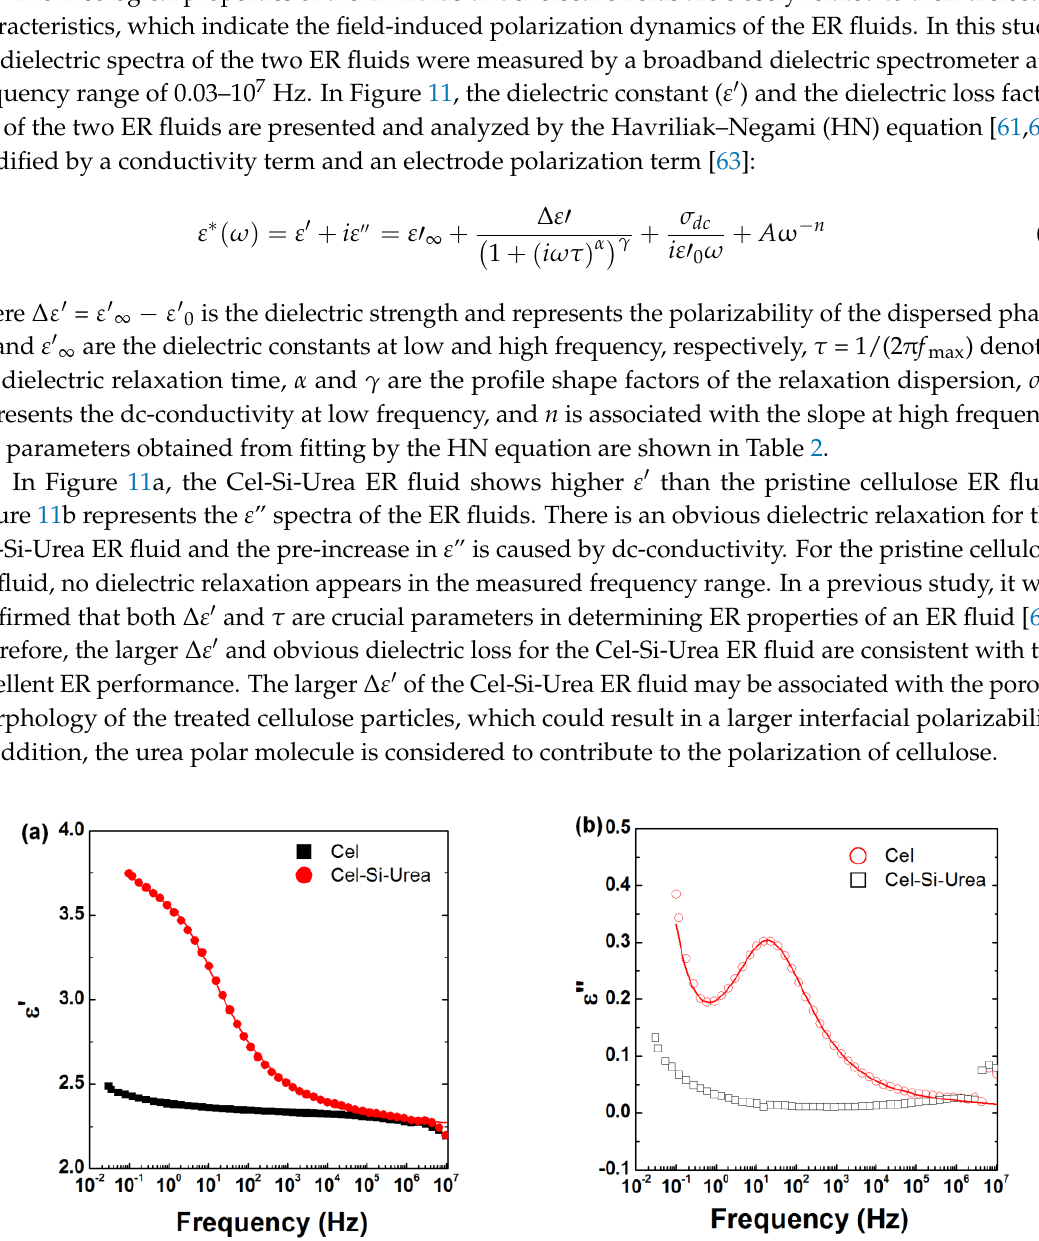
Figure 11. Dielectric spectra of the ER fluids: dielectric constant ε ′ ( a ) and dielectric loss factor ε ″ ( b ), Cel represents the pristine cellulose ER fluid and Cel-Si-Urea is for the urea-terminated silane-modified cellulose ER fluid. The solid lines were fitted using the modified HN equation. Table 2. Parameters in Equation (6) fitted from the dielectric spectra of the Cel-Si-Urea ER fluid. Cel-Si-Urea ∆ ε